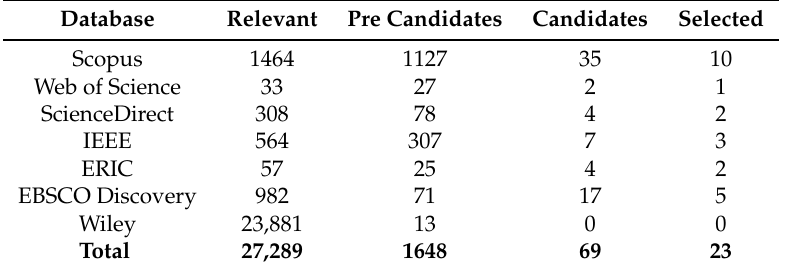
Table 2. Results of the maturity model selection focused on University Education.